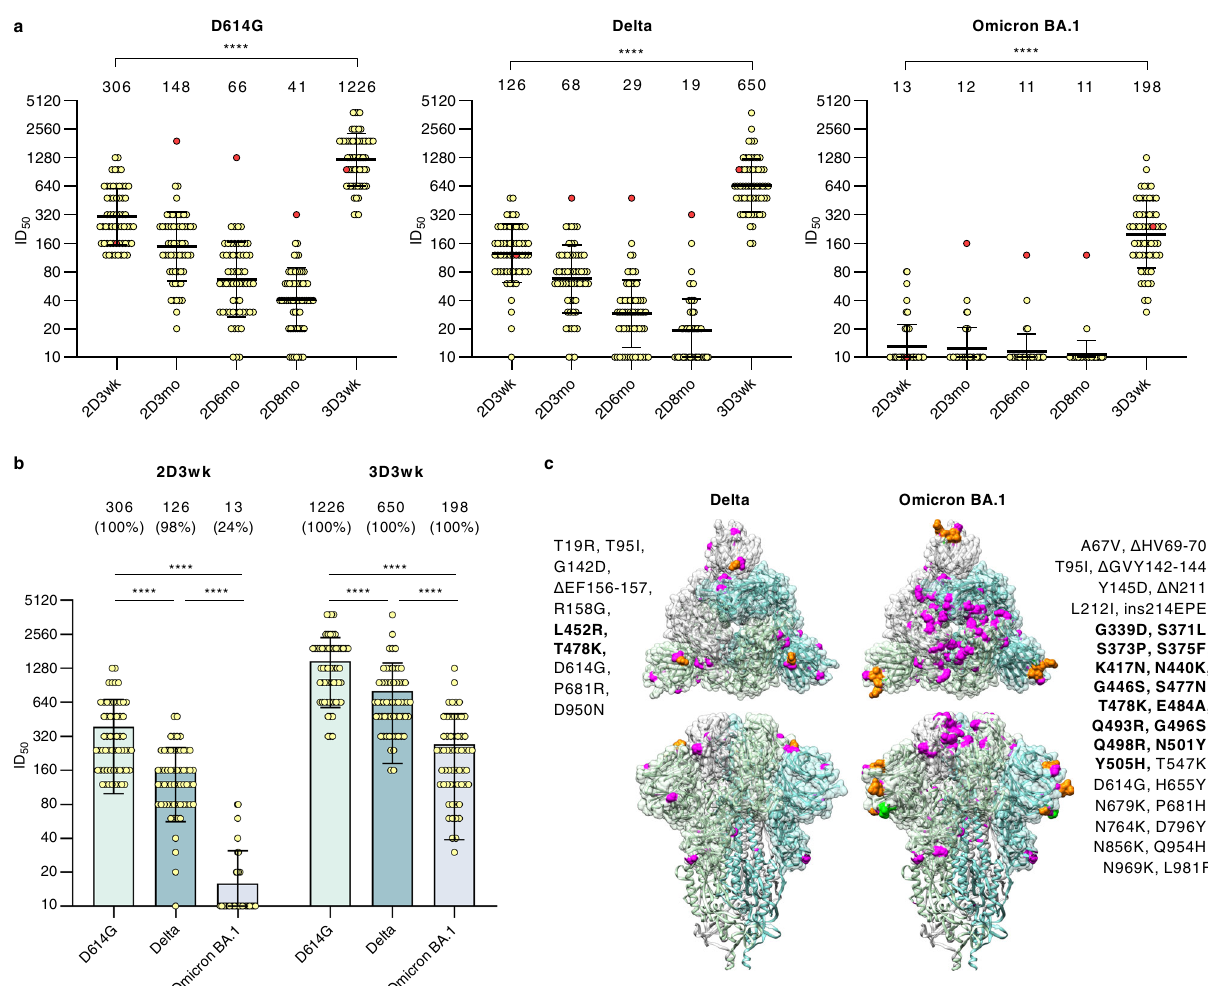
Fig. 4 Neutralizing antibodies of HCWs receiving three doses of BNT162b2 vaccine. a Neutralizing antibody responses of HCWs ( n = 59) were analyzed with a microneutralization test against SARS-CoV-2 isolates representing D614G, Delta and Omicron BA.1 variants. Serum samples were collected before the fi rst vaccine dose and three weeks after the second and the third vaccine dose. Additionally, follow-up serum samples were collected 3, 6, and 8 months after the second vaccine dose. A vaccinee with a PCR-con fi rmed SARS-CoV-2 infection after vaccination is marked with red dots. b Neutralization titers against D614G, Delta, and Omicron BA.1 variants after the second and third vaccine doses were compared. Geometric mean, shown as a line with geometric SD, is indicated above the fi gure with the percentage of positive samples when neutralization titer ≥ 20 is considered positive. Differences between neutralization titers were analyzed with two-sided Wilcoxon signed-rank test and p-values <0.05 were considered statistically signi fi cant. P -values <0.0001 are marked with ****. c Amino acid changes in Delta and Omicron BA.1 compared to Wuhan Hu-1 sequence are shown in trimeric SARS-CoV-2 spike protein structure (PDB: 6VXX). Substitutions are highlighted with magenta and deletions with orange. Changes located in the receptor-binding domain are